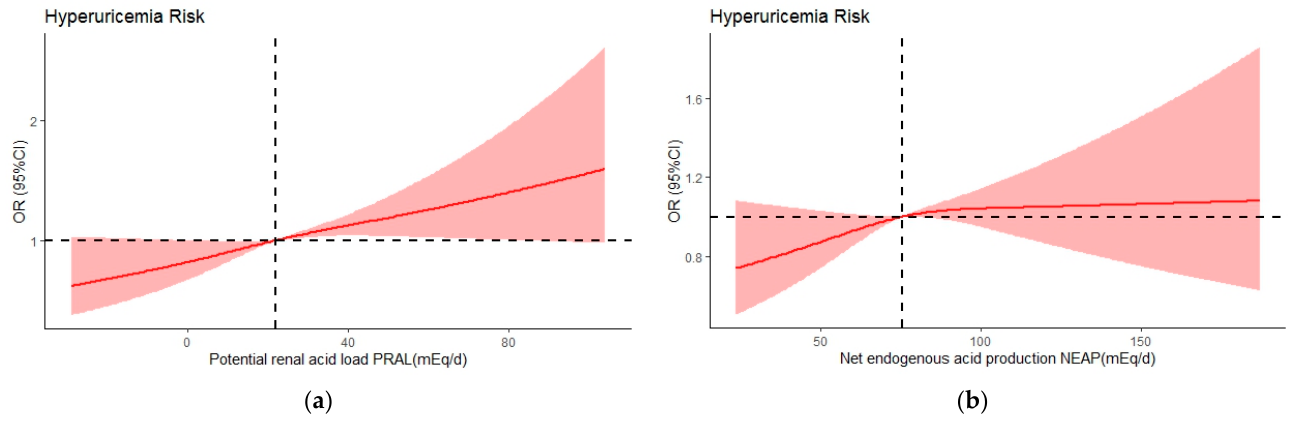
Figure 3. Multivariate adjusted odds ratios (ORs) by PRAL ( a ) and NEAP ( b ) for risk of hyperuricemia, in model 3. A knot is located at the 10th, 50th and 90th percentiles. The median intakes were set as references (gray dashed lines) (OR = 1.00). CI, con fi dence interval.